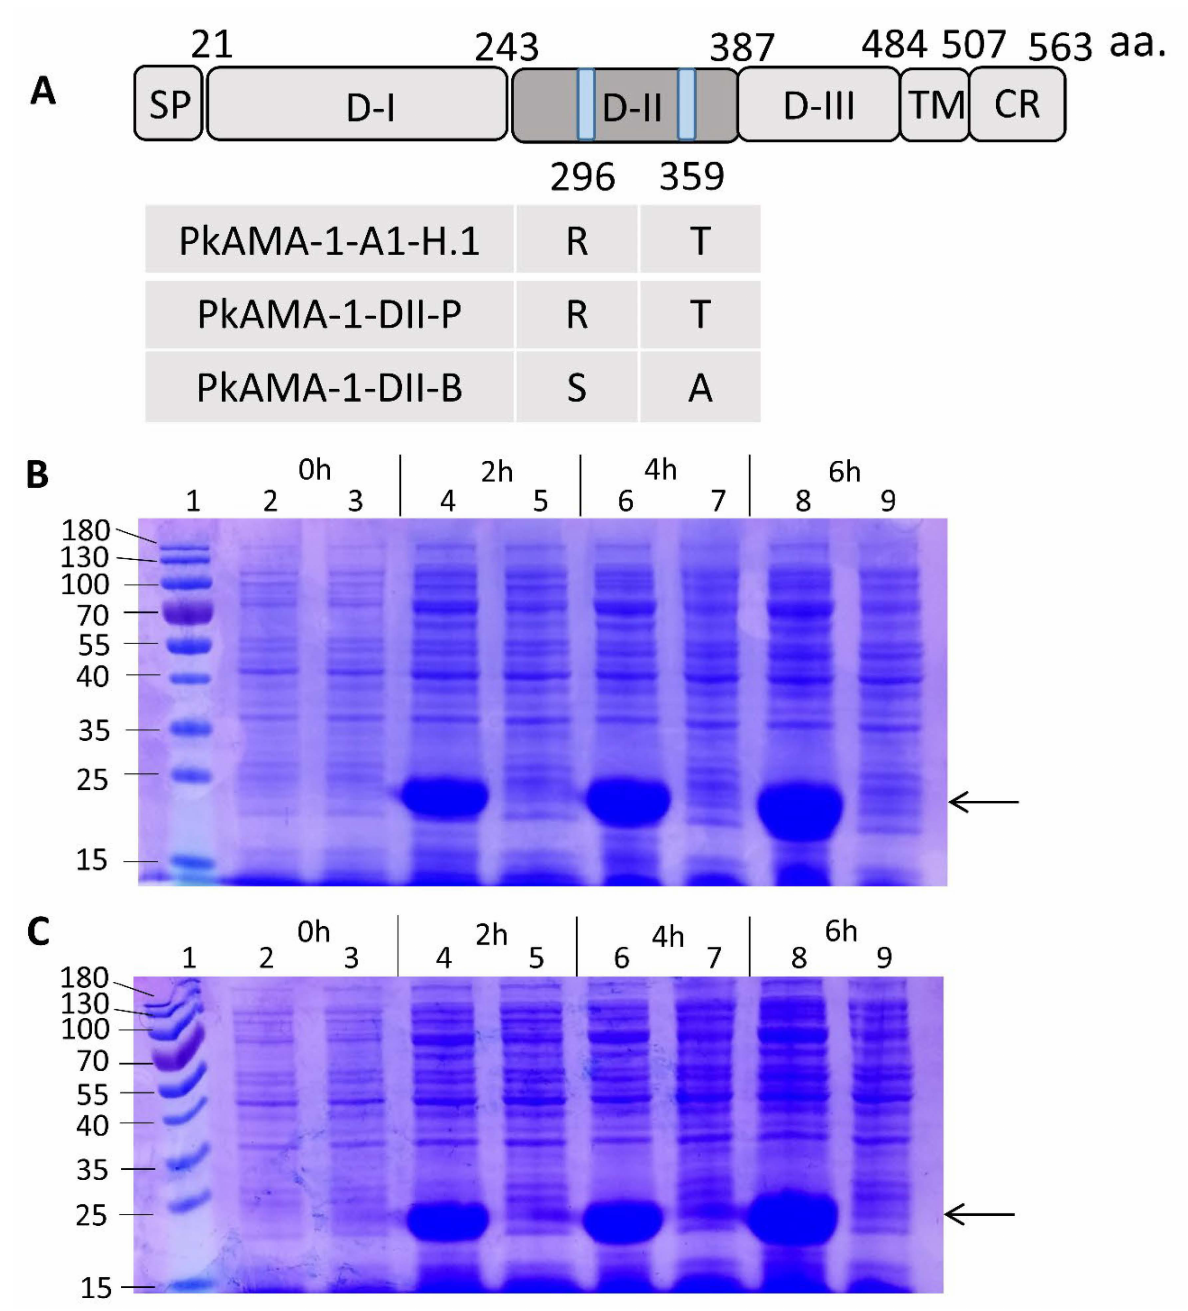
(Figure 1A). PkAMA-1-DII-P and PkAMA-1-DII-B were successfully cloned (Supplementary Figure S2A–E). Following this, recombinant proteins of PkAMA-1-DII-P (145 amino acids) (Figure 1B) and PkAMA-1-DII-B (145 amino acids) (Figure 1C) were expressed and purified (Figure 1D). Their identity was verified with Western blot (Figure 1E) and MALDI-TOF (Supplementary Figures S3 and S4).